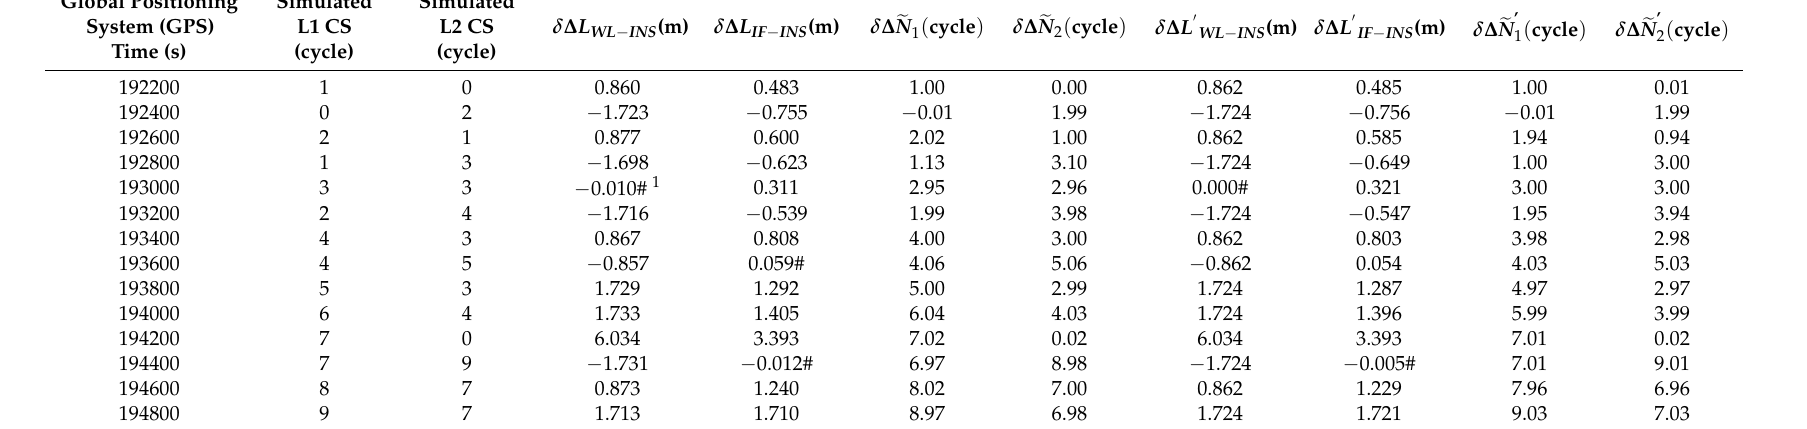
Table 1. Simulated cycle slip values, corresponding detection models, and real cycle slip solutions for PRN13. Global Positioning System